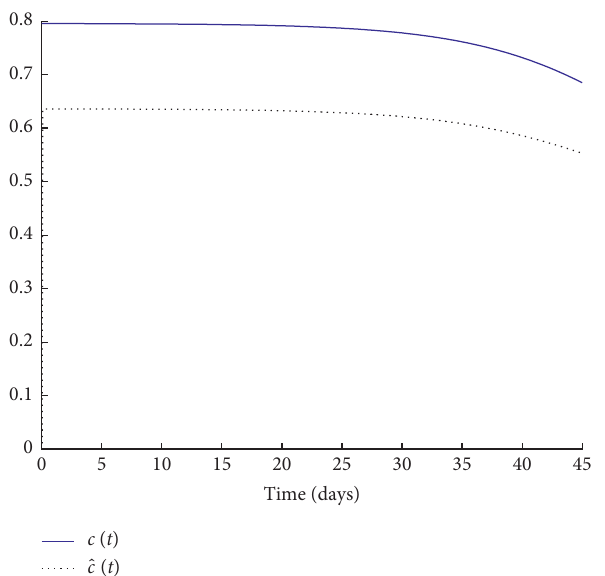
Figure 9: Estimation of the carrying capacity from the SIR model.